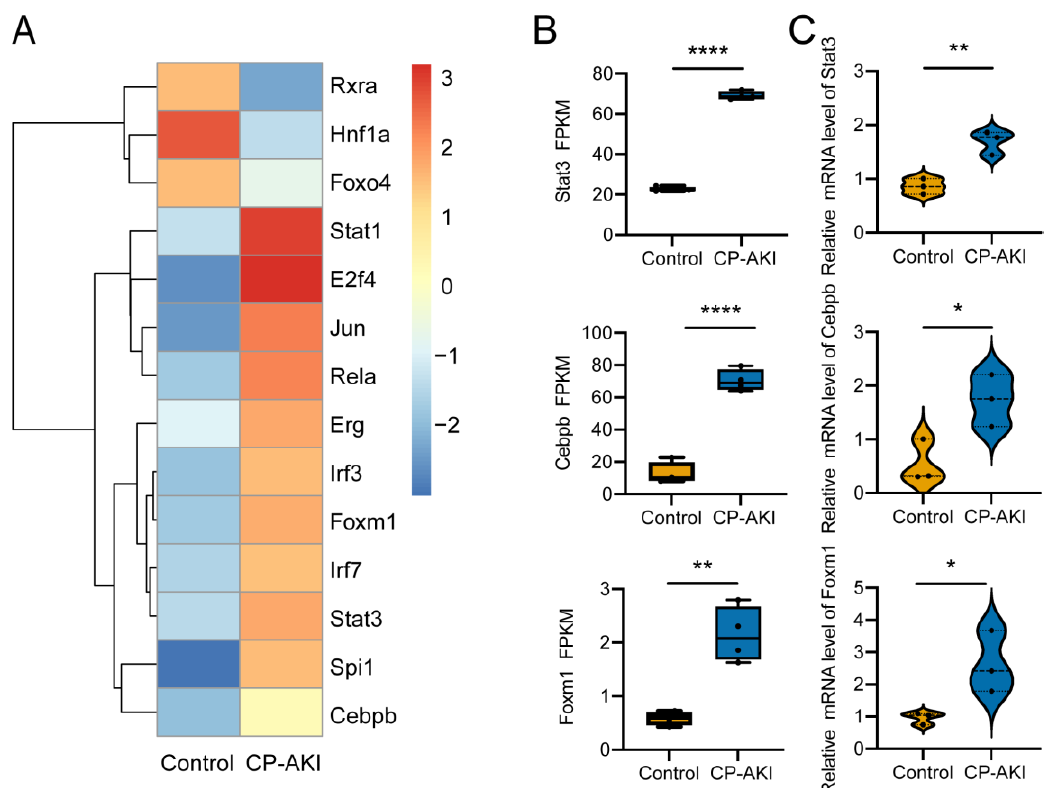
Figure 6. Classification of transcription factors (TFs): CP-AKI versus control mice. ( A ) Activated TFs in CP-AKI and control mice. ( B ) Relative expression (FPKM) levels of Stat3 , Cebpb , and Foxm1 from RNA-seq results ( n = 4). ( C ) Validation of Stat3 , Cebpb , and Foxm1 expression levels by RT-qPCR between the two groups ( n = 3, respectively). * p < 0.05, ** p < 0.01, **** p < 0.0001.